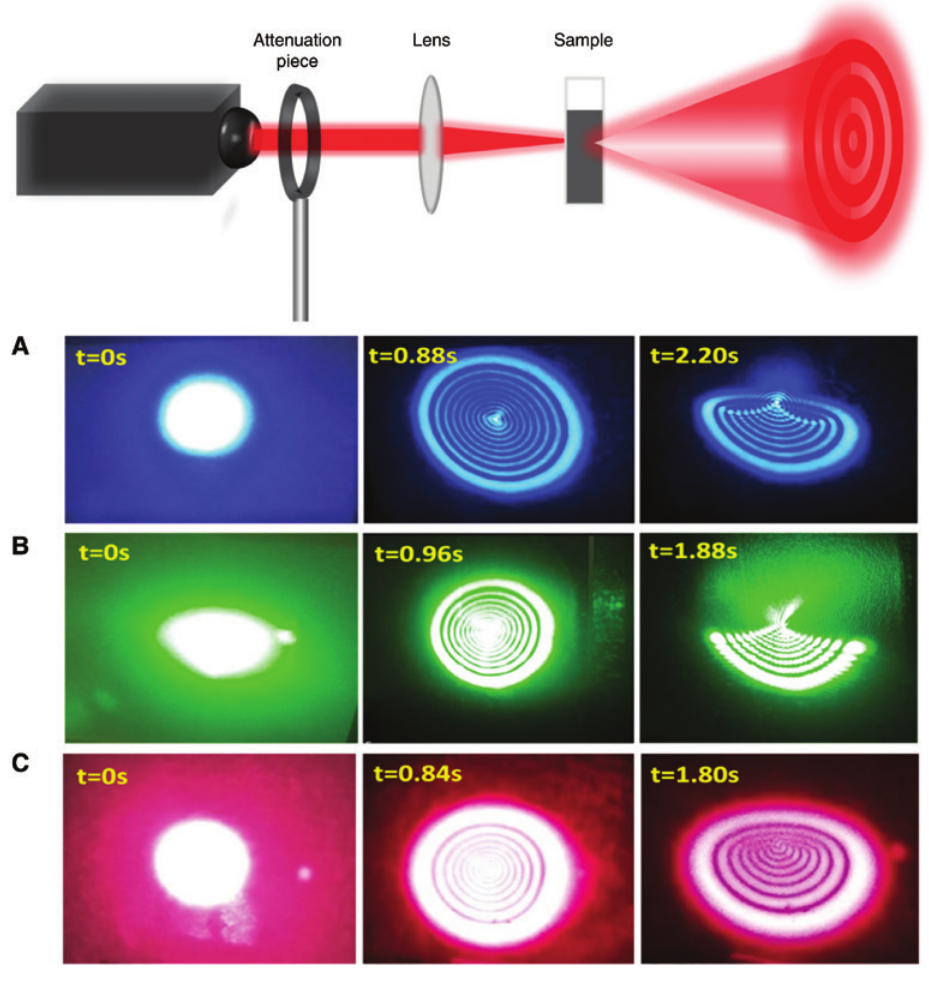
Figure 2: The experimental facility diagram of